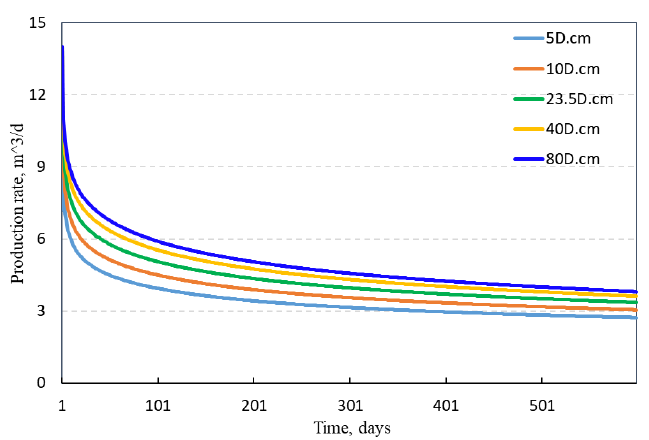
Figure 17. Production curves of conductivity effect.